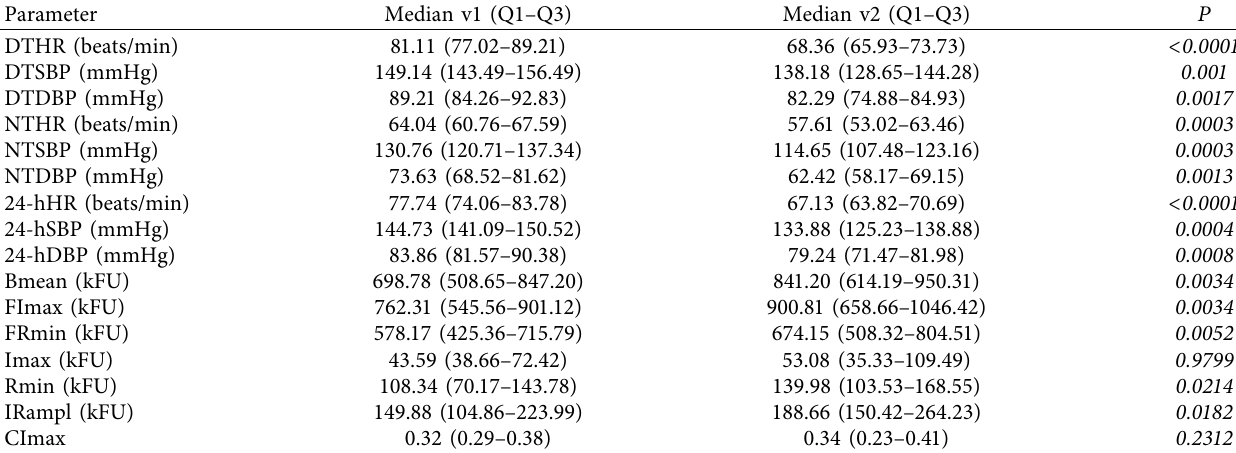
Bmean, mean fluorescence recorded before ischemia as the baseline value; FImax, the maximal fluorescence above the baseline during ischemia; FRmin, the minimal fluorescence below the baseline during reperfusion; Imax, the difference between FImax and Bmean; IRampl, the difference between FImax and FRmin; Rmin, the difference between Bmean and FRmin; CImax, Imax/IRampl rate; 24-hSBP, 24-hour systolic blood pressure; 24-hDBP, 24-hour diastolic blood pressure; 24-hPR, 24-hour pulse rate; DTSBP, day time systolic blood pressure; DTDBP, day time diastolic blood pressure; DTPR, day time pulse rate; Table 5: Summary of continuous measures for hypertensive patients assigned to metoprolol at 50mg BID. P values of the paired analysis of continuous data with a nonparametric Wilcoxon test for comparison of results before and after the six-week treatment. Parameter Median v1